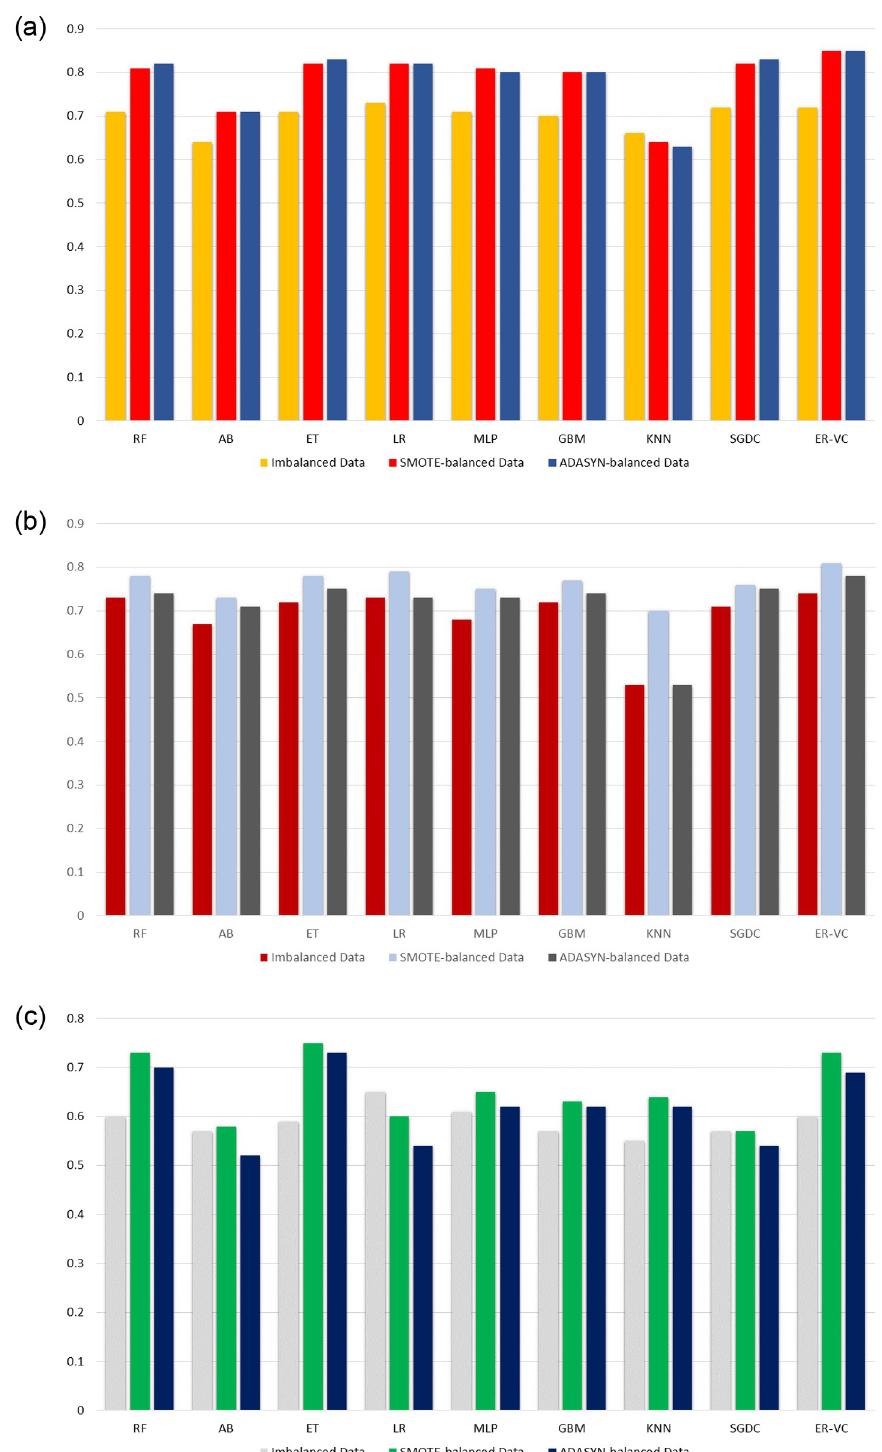
Fig 6. Performance analysis of ML models, (a) accuracy using TF-IDF with and without SMOTE, (b) accuracy using BoW with and without SMOTE, and (c) accuracy using GloVe with and without SMOTE.